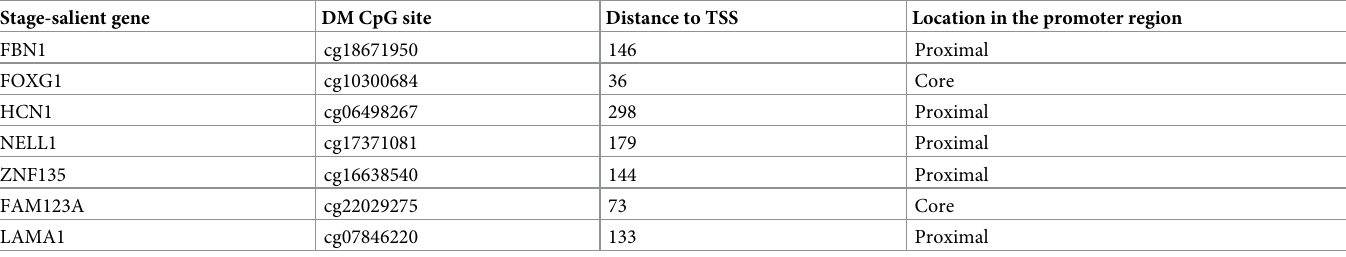
Table 8. Location of the major DM CpG site in stage-salient genes. Stage-salient